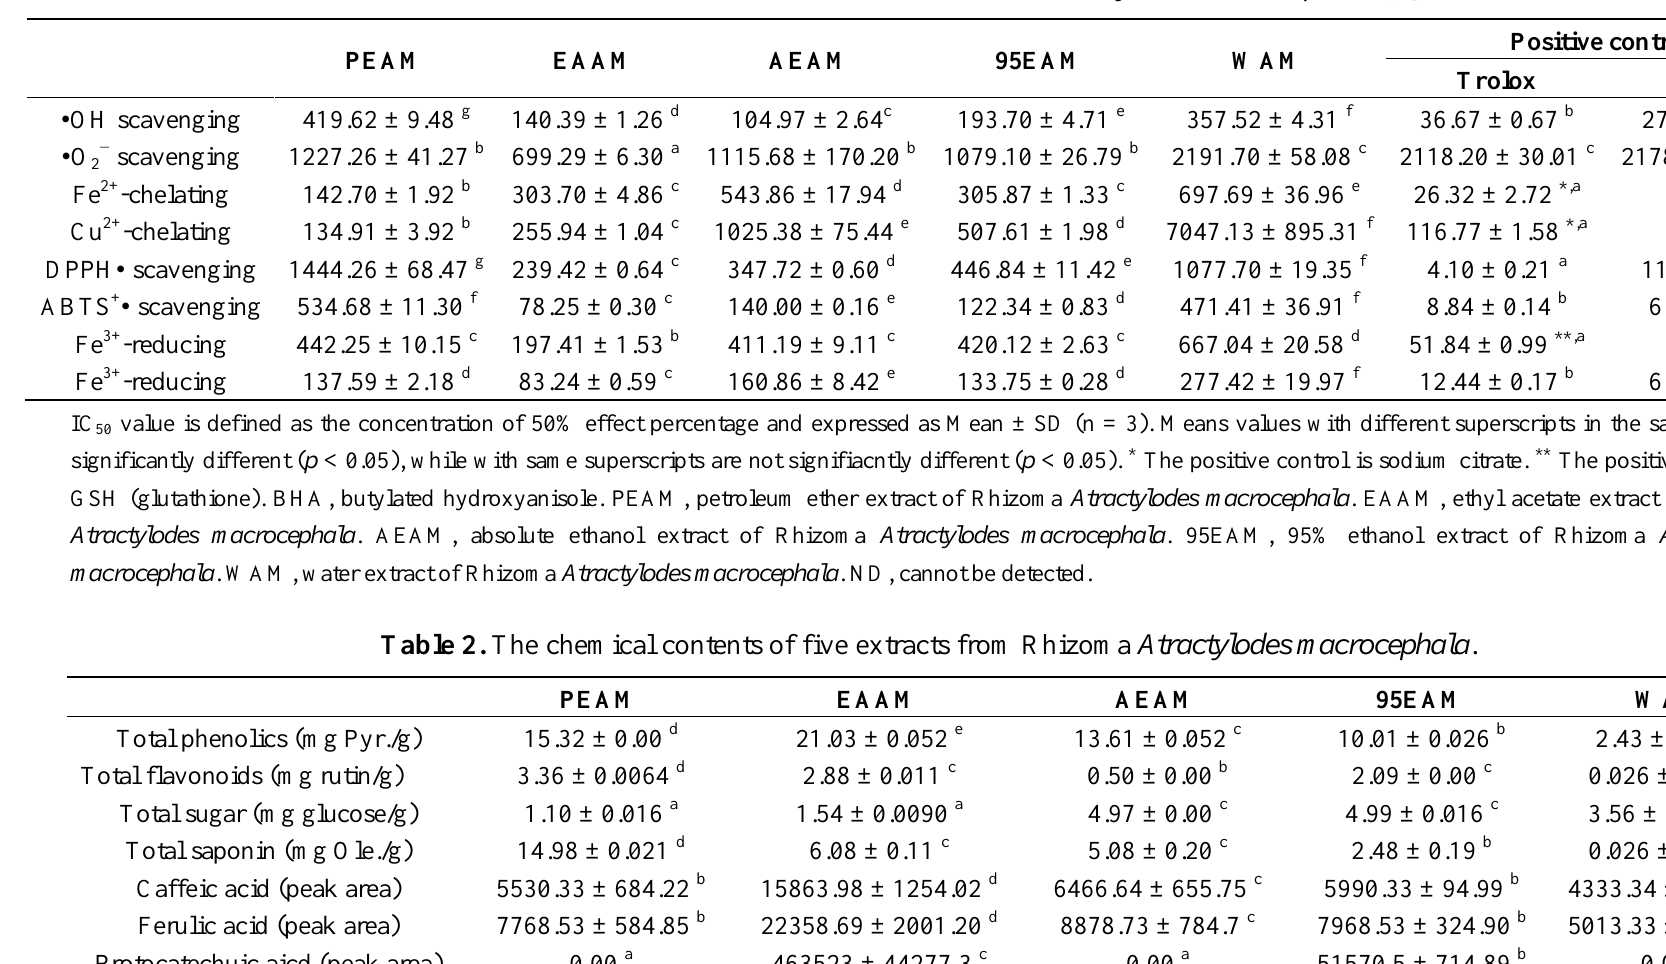
Table 1. The IC values of five extracts from Rhizoma Atractylodes macrocephala (µg/mL). 50